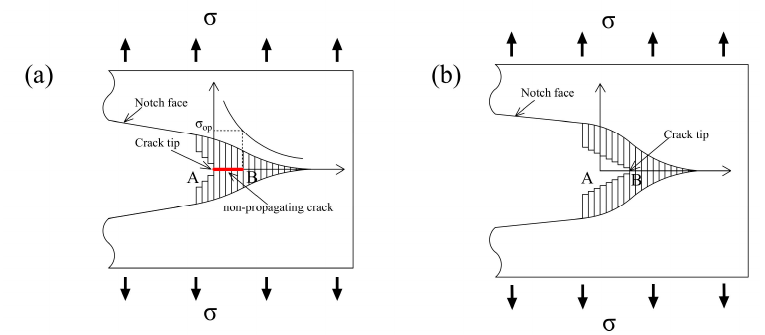
Figure 9. Schematic illustration of plasticity-induced crack closure model. ( a ) crack tip initial position; ( b ) Position of crack tip when non-propagating crack stops growing .